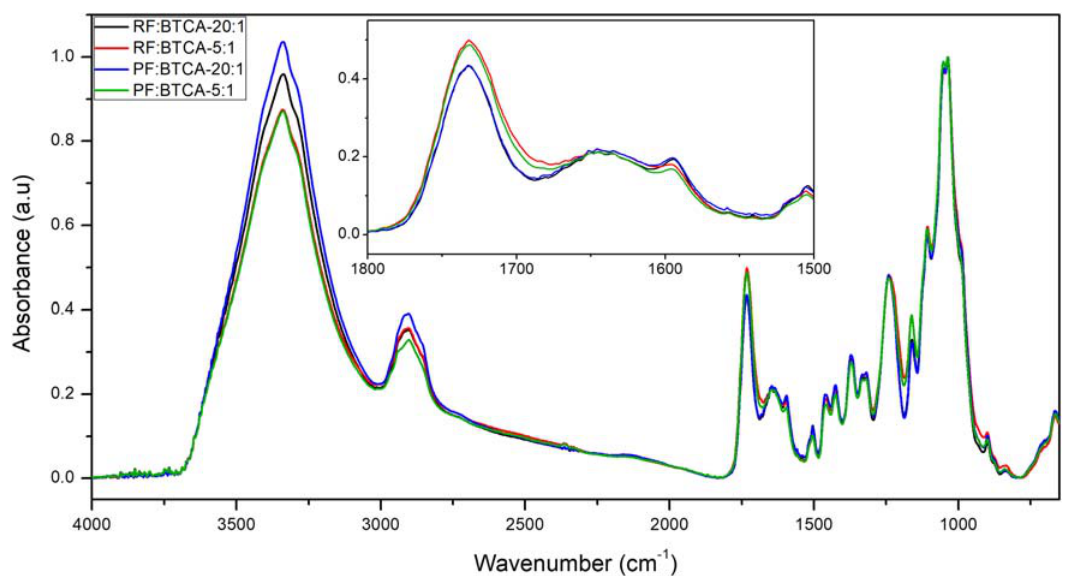
Figure 3: FTIR spectra for all fi bers crosslinked at di ff erent BTCA ratios.